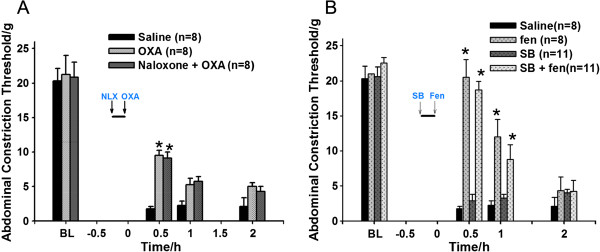
The OXA analgesic effect was not blocked by intrathecal administration of naloxone (A). The fentanyl-induced analgesic effect was not blocked by intrathecal administration of SB-334867 (B). Data are presented as the mean ± SEM. *P<0.05 versus saline group. Short black line represents the surgery duration. BL: baseline; NLX: naloxone; Fen: fentanyl; SB: SB-334867.